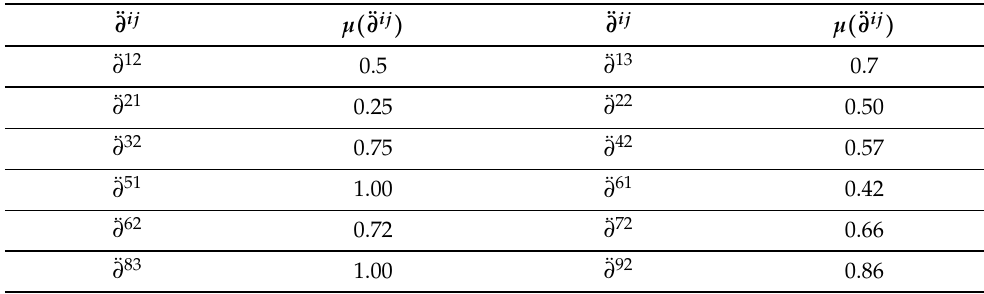
Table 4. Fuzzy membership corresponding to each ¨ ∂ ij